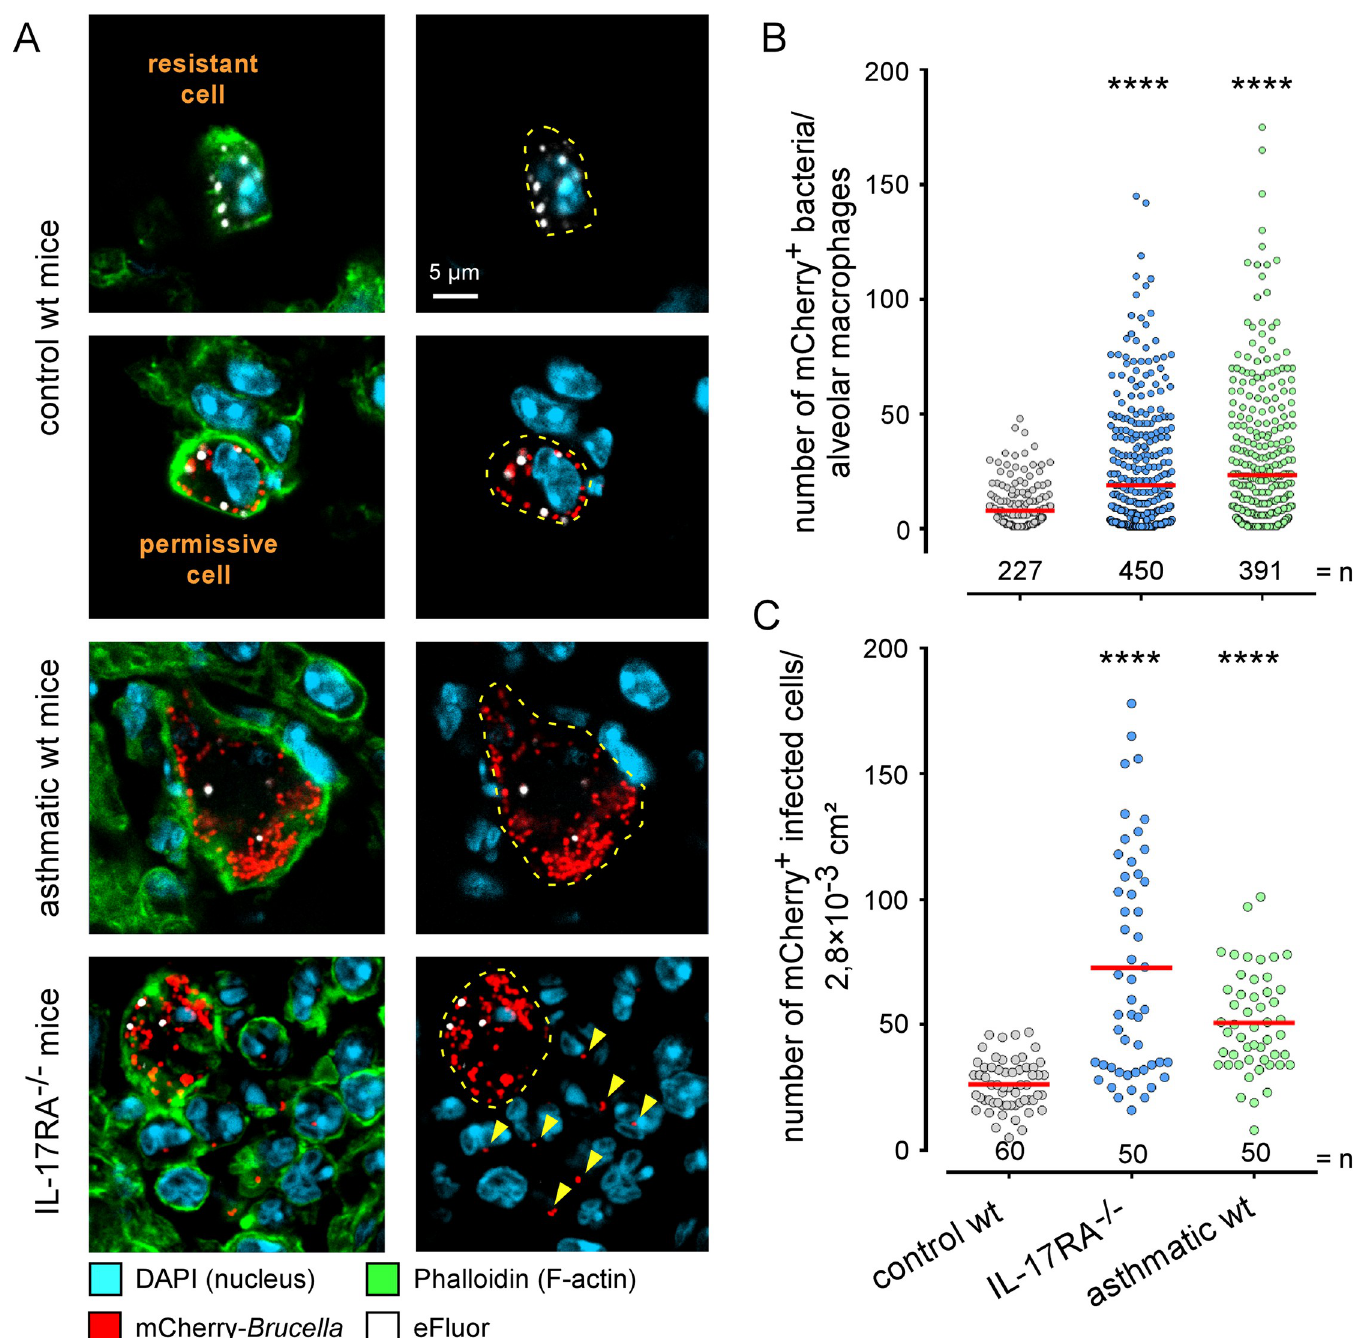
Fig 9. IL-17RA deficiency and asthma induce distinct patterns of infection in the lung. Control and asthmatic wild-type C57BL/6 mice and IL-17RA -/- mice were infected intranasally with a dose of 5x10 7 CFU of mCherry- B . melitensis labelled with eFluor 670 . Mice were sacrificed at 48 hours post-infection and the lungs were collected and analyzed by confocal and fluorescent microscopy for the expression of DAPI, phalloidin, mCherry and eFluor 670 markers. Data shown are ( A ) representative confocal images (single z-plane) of infected cells, ( B ) the number of mCherry + bacteria / alveolar macrophages and ( C ) the number of mCherry + bacteria per lung surface unit determined by fluorescent microscopy. In order to avoid biases in the analysis, an automatic acquisition of the entire surface of the tissue section is carried out using MosaiX module from AxioVision program (Zeiss). We exclude from this analysis the edges of the organ as well as the damaged areas. n indicates the number of cells analyzed ( B ) or the number of surfaces analyzed ( C ) for each condition. Significant differences between control wt and the indicated groups are marked with asterisks: ���� p < 0.0001, in a One-Way ANOVA with Kruskal-Wallis post-test. The data are representative of two independent experiments.